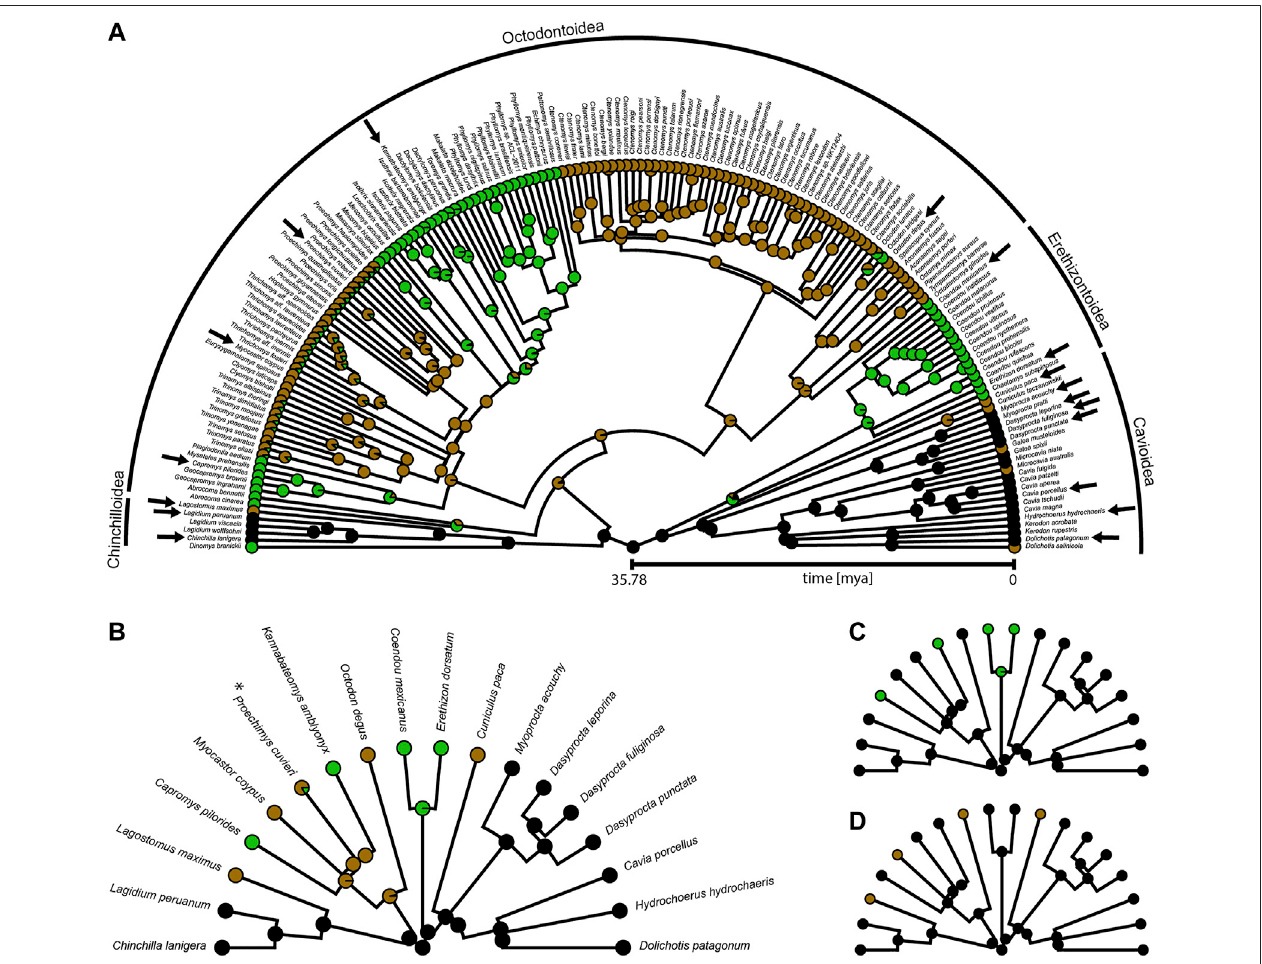
FIGURE2| PhylogenyofCaviomorphawithreconstructed lifestyles.Piechartsattipsandnodesindicate posteriorprobabilitiesoflifestyles. (A) Originalphylogeny containing all available species from Hedges et al. (2015). Cursorial category in black, fossorial category in brown, and scansorial category in green. Arrows indicate species included in our dataset. (B) Phylogeny and mapping from (A) after pruning to match our dataset for fi tting an Ornstein-Uhlenbeck (OU) model with three optima (see text). Color coding as in (A) . Asterisk indicates the species that was used instead of P. mincae (see text). (C) Pruned phylogeny and mapping for fi tting an OU modelwithtwooptima.Terrestrialcategoryinblackandscansorialcategoryingreen.Theoriginalmappingwithallspeciesbeforepruningisprovidedin Supplementary Figure S1A . (D) Pruned phylogeny and mapping for fi tting an OU model with two optima. Overground category in black and fossorial category in brown. The original mapping with all species before pruning is provided in Supplementary Figure S1B